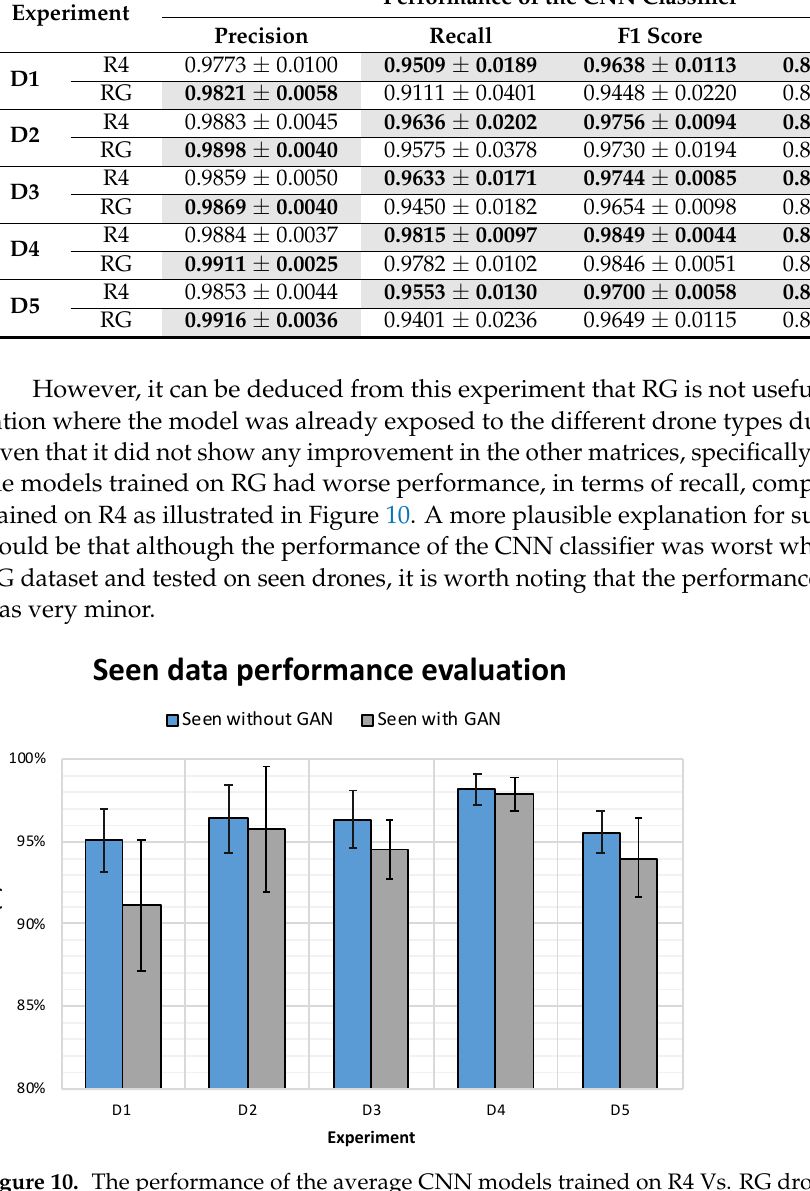
Table 15. The average results of the testing on Seen Drones for every D experiments. Performance of the CNN Classifier Experiment